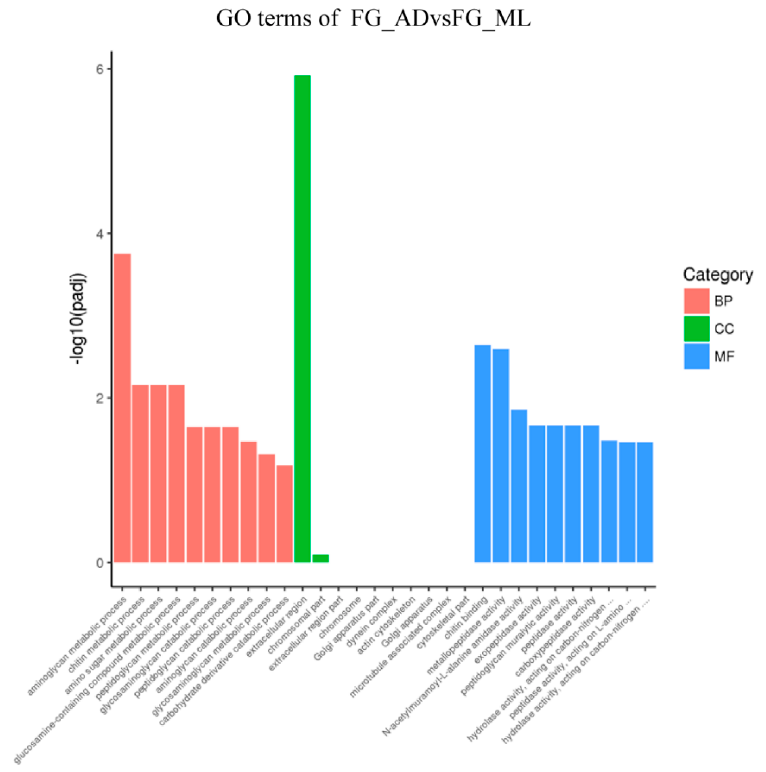
Figure 5. GO enrichment of FG_ADvsFG_ML. The differentially expressed genes were mainly related to biological processes (BP) such as aminoglycan metabolic process, chitin metabolic process, amino sugar metabolic process and glucosamine-containing compound metabolic process; cell components (CC) only related to extracellular region and chromosomal part, and the molecular functions (MF) such as chitin binding, metallopeptidase activity, N-acetylmuramoyl-L-alanine amidase activity.